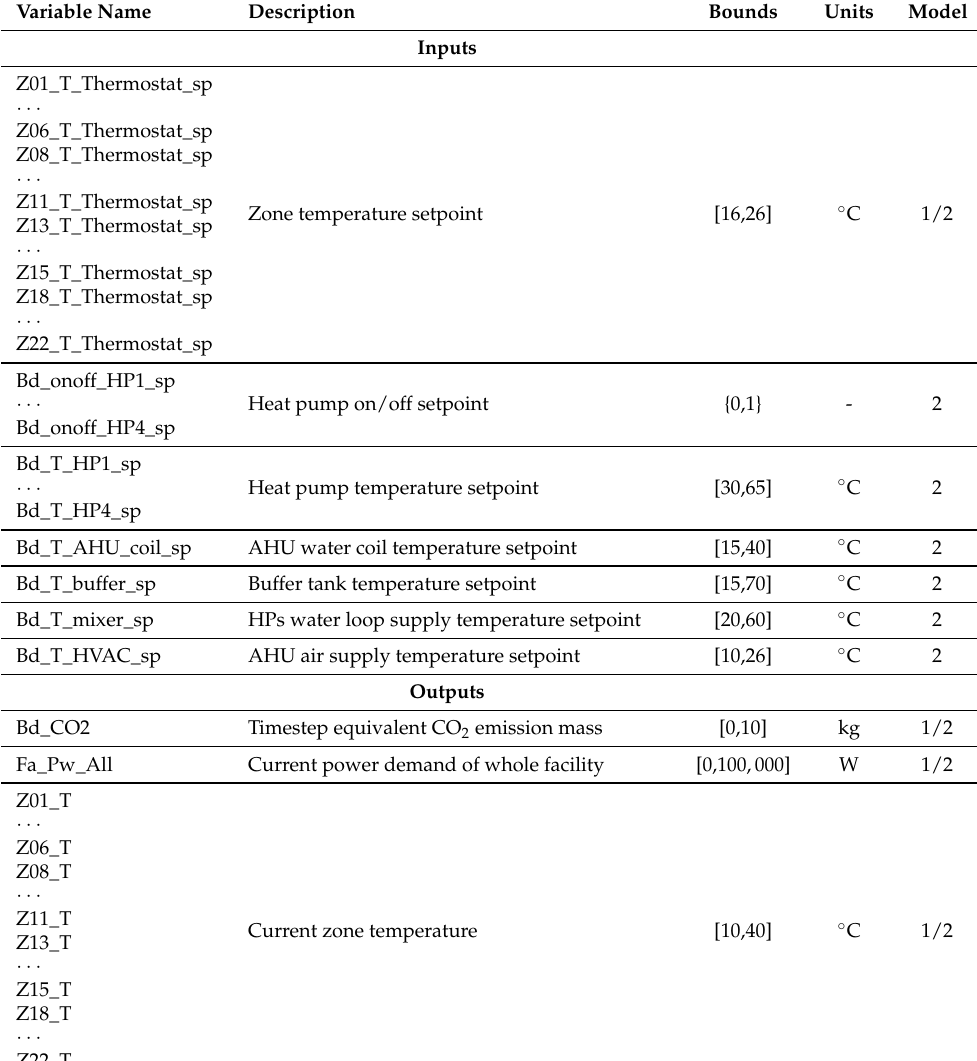
Table A5. Inputs and outputs for the models SeminarcenterThermostat-v0 (1) and SeminarcenterFull- v0